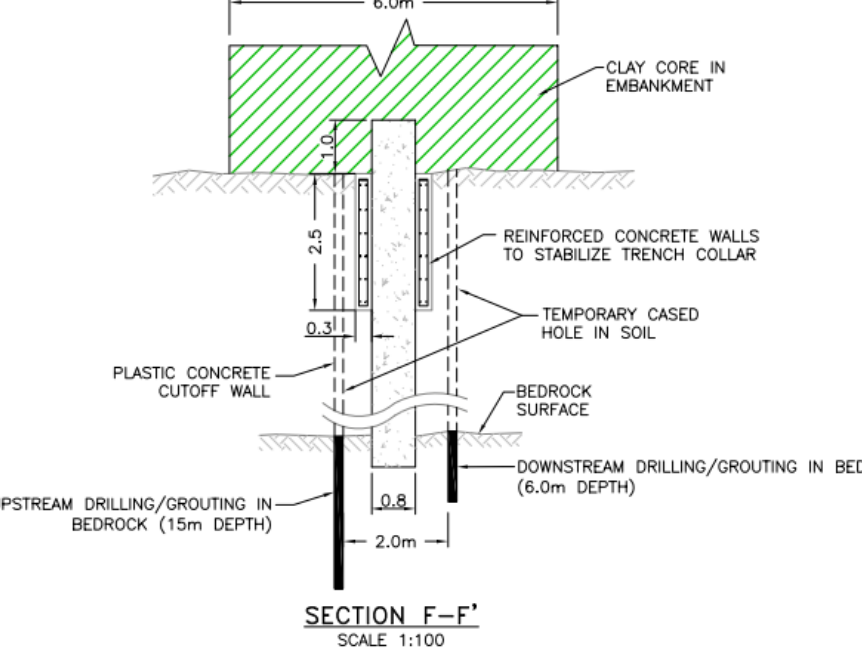
Figure 9. Example of detail of plastic concrete slurry wall with cement–bentonite grout curtain in TSF.